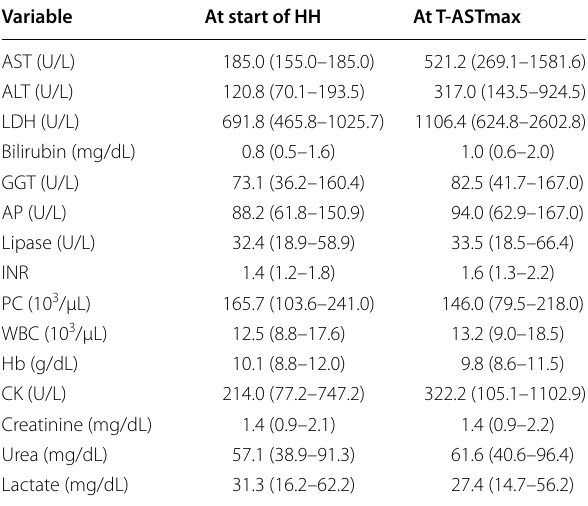
Table 4 Median laboratory values (Q1–Q3) at different time